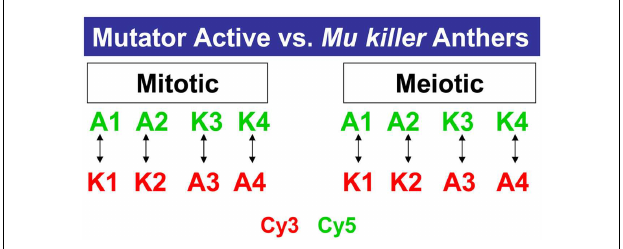
FIGURE 7 | Microarray profiling experimental design. Four biological replicates of Mu active (A) or Mu killer (K) maize anthers were collected for two stages. For each stage, two samples were labeled with the Cy3 fluor (Green) or Cy5 fluor (Red) and hybridized as shown on the 4K × 44K Agilent maize oligonucleotide array